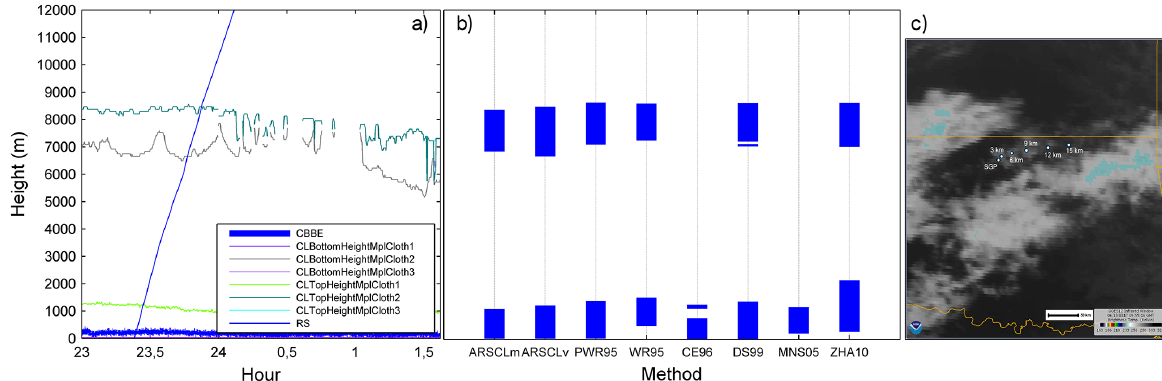
Figure 6. Idem as Fig. 3, but for Case 4: 5 October 2009, two layers of clouds: low and high clouds. RS launch time: 23:28UTC. GOES infrared image at 00:15UTC (6 October